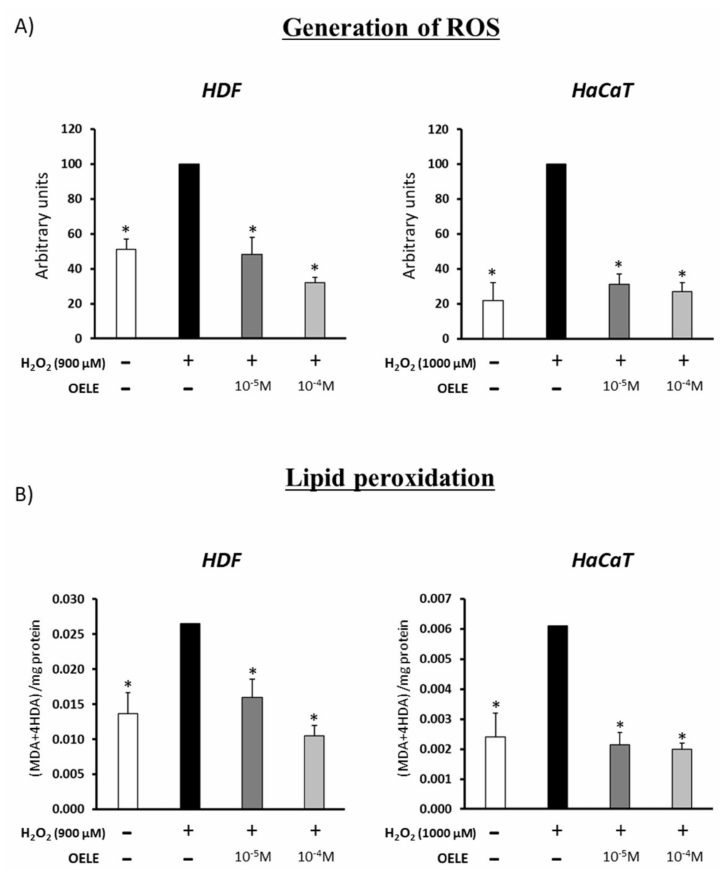
Figure 3. Protection of OELE co-treatment against oxidative damage induced by H 2 O 2 treatment. ( A ) Generation of ROS in human dermal fibroblasts (HDF) and epidermal keratinocytes (HaCaT) after H 2 O 2 treatment in the presence or absence of OELE (10 − 5 or 10 − 4 M of oleuropein). ( B ) Lipid peroxidation in cultures of (HDF and HaCaT treated as in A). * p < 0.05 vs. control + H 2 O 2